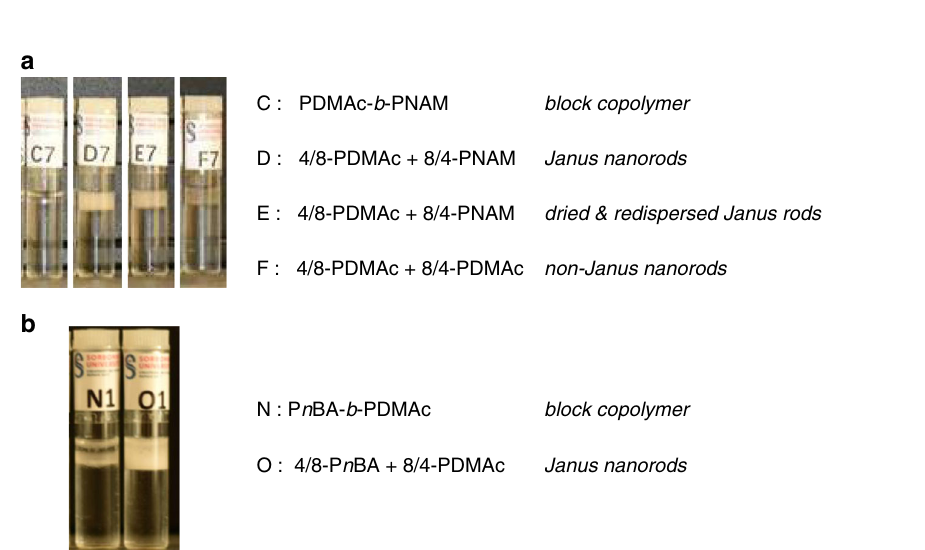
Fig. 3 Emulsions. a Water/ethyl acetate (80/20) mixtures with various additives (1 g L − 1 ), 2 weeks after shaking. The cloudy phase corresponds to ethyl acetate droplets that have creamed but have not coalesced (see Supplementary Fig. 38). b Water/ β -pinene (80/20) mixtures with additives (25 mg L − 1 ), 2 weeks after vortexing. The letters indicate the nature of the additive (see